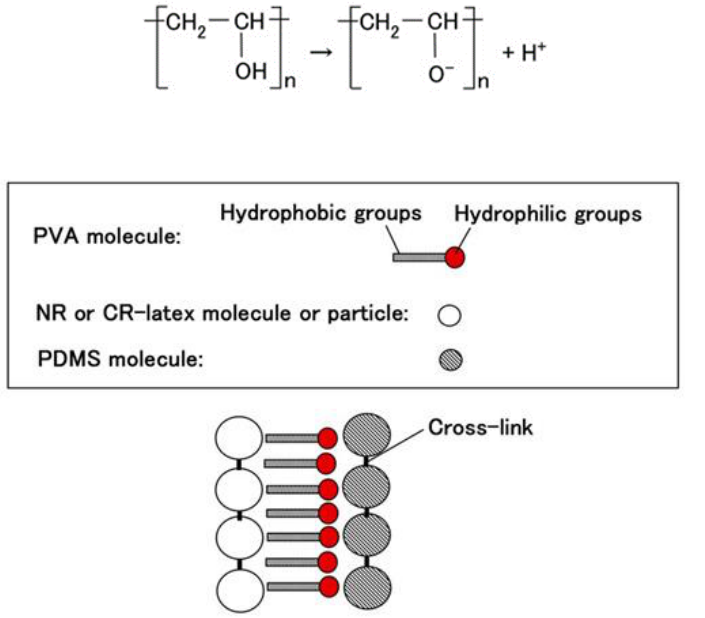
Figure 1. Schematic diagram of hydrophilic and hydrophobic group of PVA, and emulsion polymerization between PDMS and NR- or CR-latex.